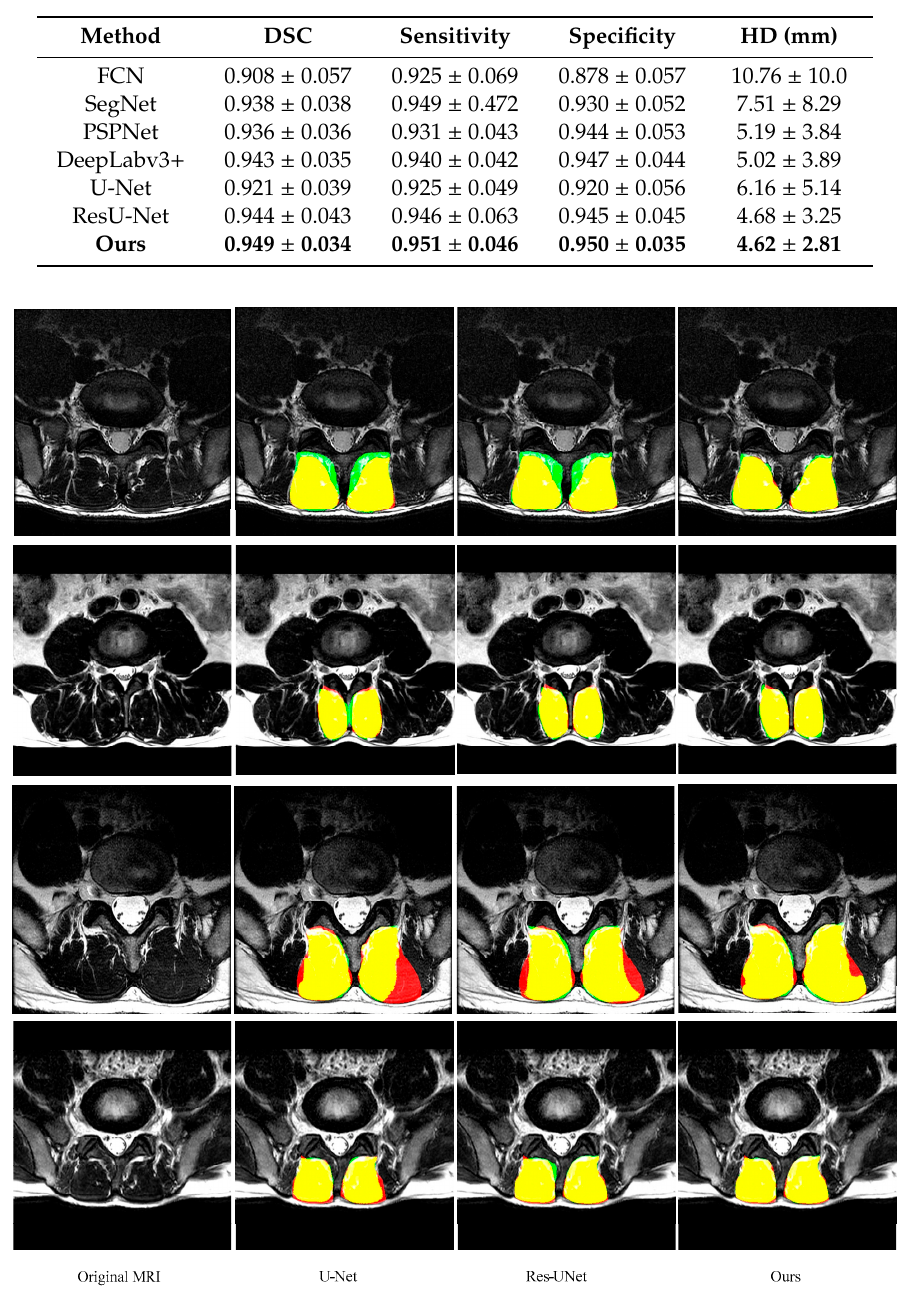
Figure 6. Representative cases of the segmentation results of the MF (green is predicted segmentation, red is ground truth mask and yellow is the overlap region) obtained by U-Net, ResU-Net, and our segmentation network. These images are from different patients and shown in the axial view.